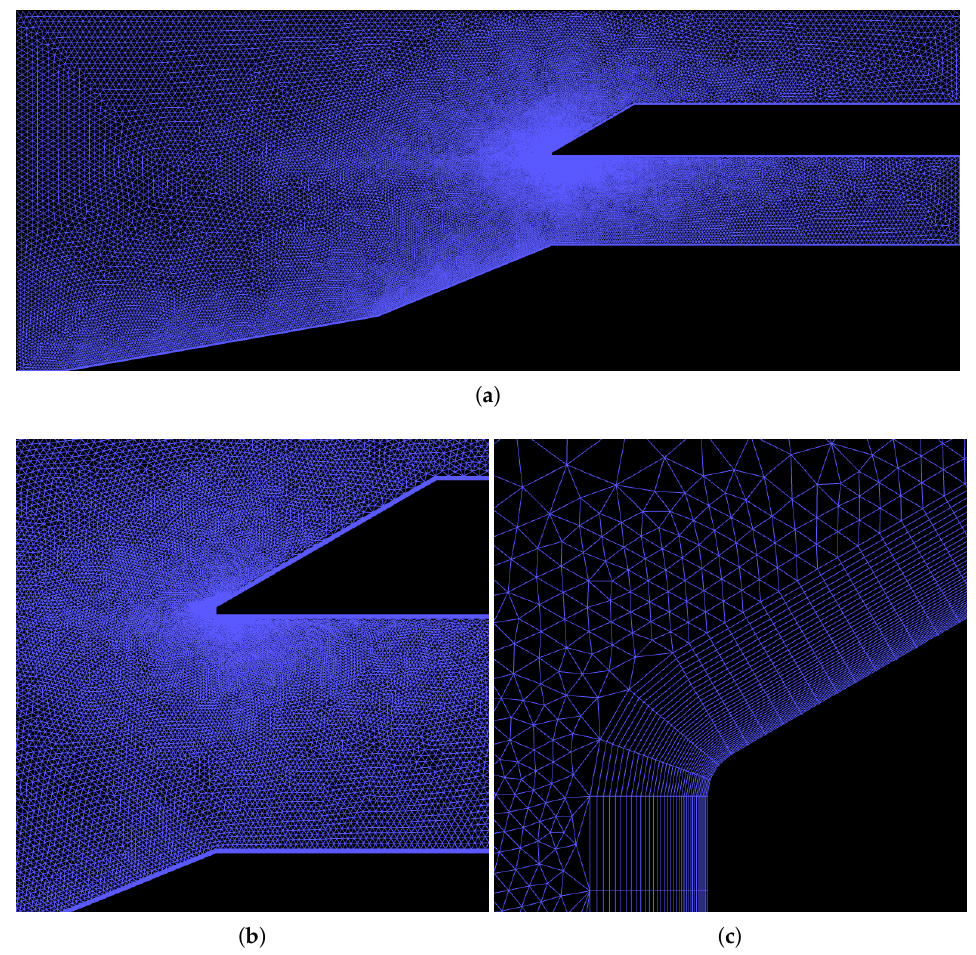
Figure 2. Mesh overview ( a ) and details ( b , c ). The figures refers to the fine grid of 300 k elements. ( a ) Mesh overview; ( b ) Mesh details over the channel entrance; ( c ) Mesh enlargement at the cowl